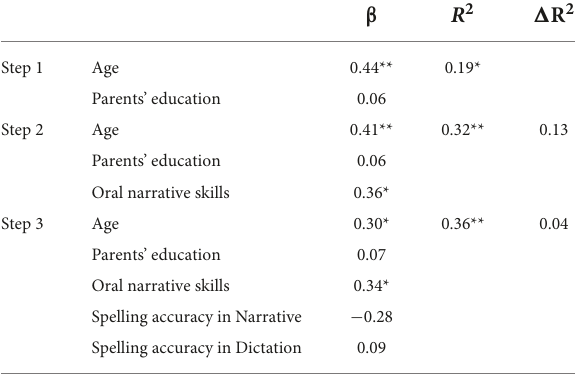
TABLE 4 Stepwise regression for monolingual children (dependent variable: written narrative skills).